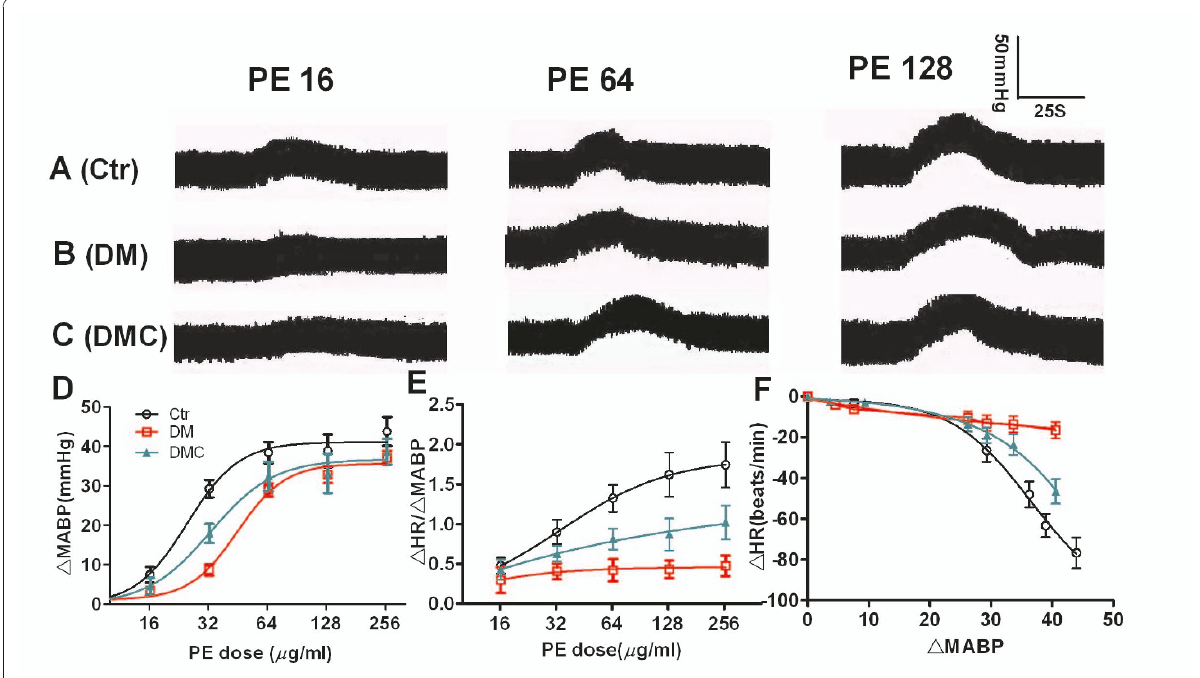
Figure 3 Effect of DMC on the attenuation of baroreflex sensitivity in DM rats following PE administration . A: Normal rat (Ctr). B: DM rat (DM). C: DMC-treated DM model rat (DMC). Trace: blood pressure changes induced by PE application at 16, 64, and 128 μ g/ml. D) Dose dependent Δ MABP curve of rats; E) Dose dependent Δ HR/ Δ MABP curve of rats; F) Correlation of Δ HR to Δ MABP in rats at different PE dosages. n =